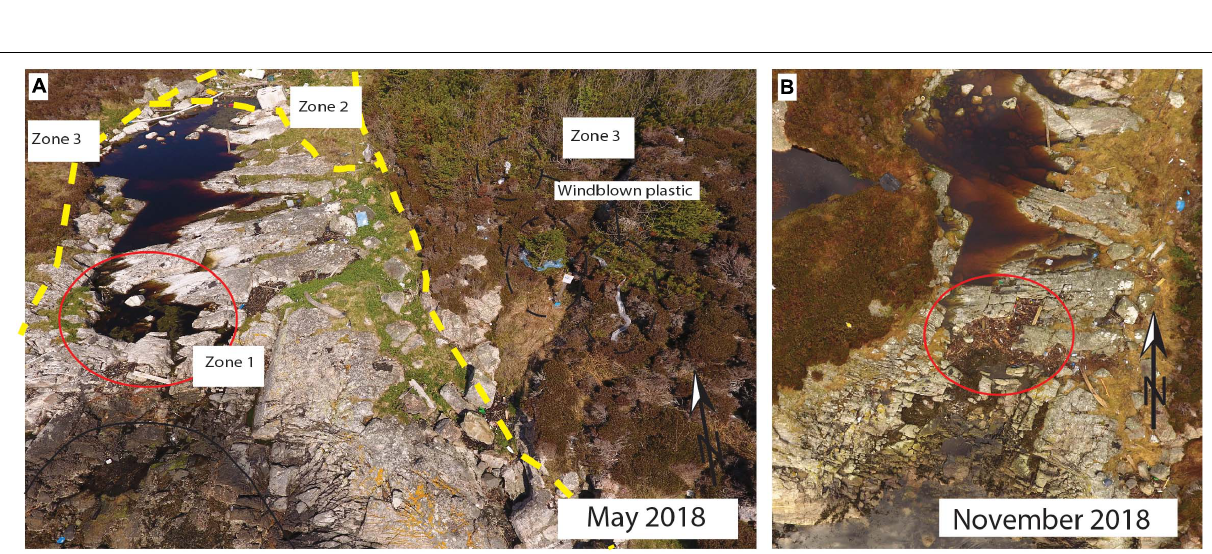
Frontiers in Marine Science |